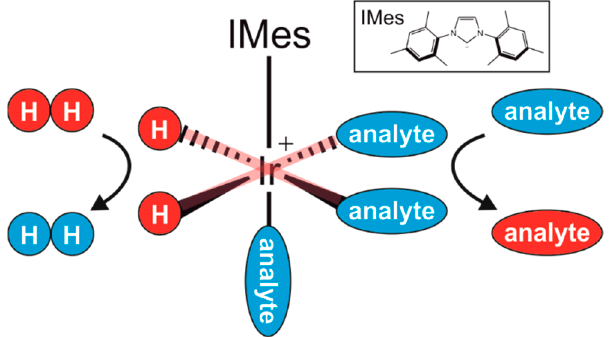
Figure 1. A schematic representation of the signal amplification by reversible exchange (SABRE)- polarisation transfer process. Hyperpolarisation is catalytically transferred from the nuclear singlet isomer of hydrogen, para hydrogen ( p- H 2 ), to the target analyte via the J coupling network of the active SABRE catalyst. Rapid reversible exchange of the analyte and p- H 2 on the catalyst leads to a buildup of hyperpolarised analyte in solution over a period of seconds. In general, this process is optimised in a weak magnetic field of 0–20 mT. The active SABRE catalyst is a positively charged Ir(III)